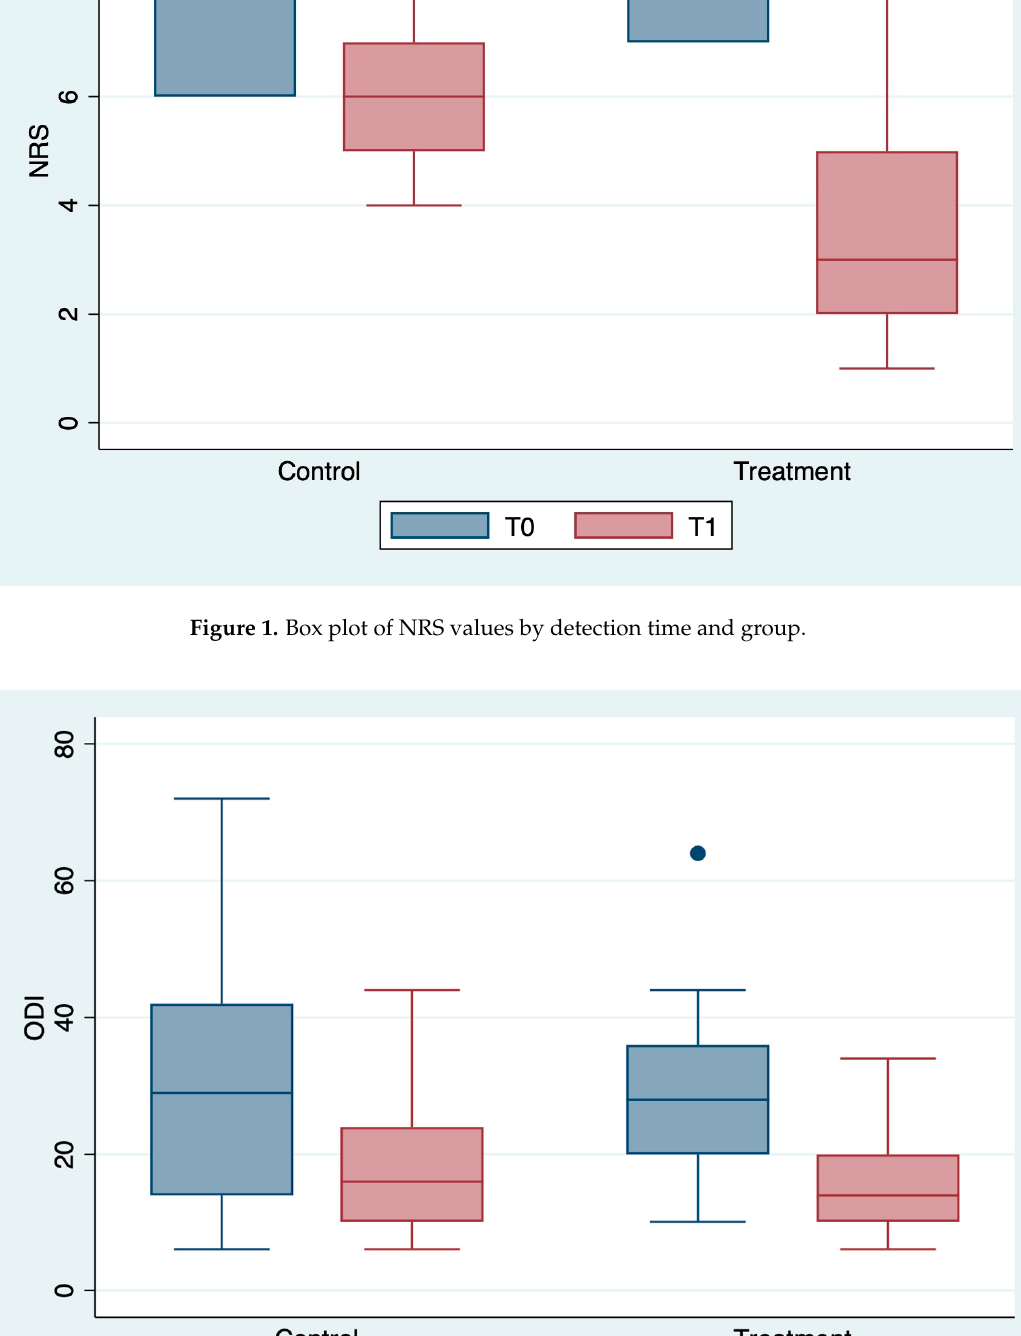
Figure 3. Box plot of PCS ‐ 12values by detection time and group.